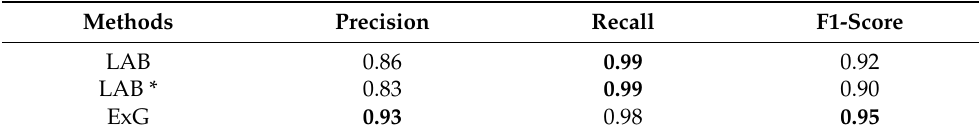
Table 2. The results of instance segmentation on testing set. The confidence threshold is 0.5. The IoU threshold is 0.5. Bold is the best result compared with other methods. * indicates that the model training time is longer. All model results are without weed